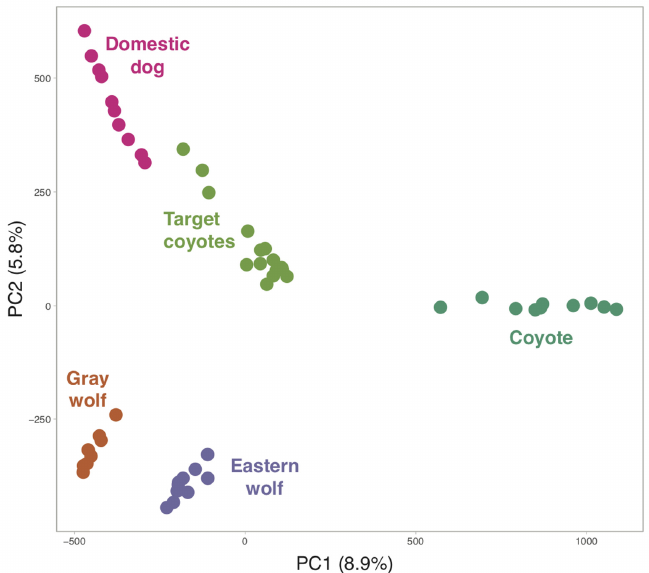
Figure 2. PCA of 53 canids genotyped at 16,355 unlinked and neutral SNP loci. The percent of variation explained by each axis is provided in parentheses. The 15 target coyotes were sampled in the New York City metropolitan area. Table 1. Autosomal ancestry proportions for each of the 15 target coyotes sampled in the New York metro area and inferred from 26,763 SNP genotypes across two reference populations (domestic dog, Cfa; western coyote, Cla).